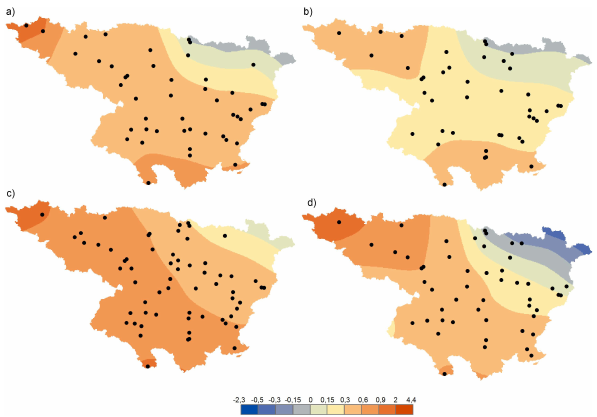
Fig. 7. Per decade change in the number of daily rainfall erosivity events corresponding to the first (Q1) quintile at the seasonal scale for the period 1955–2006: (a) DJF, (b) MAM, (c) JJA, (d) SON. Black circles indicate significant trends at the α = 0 . 05 confidence